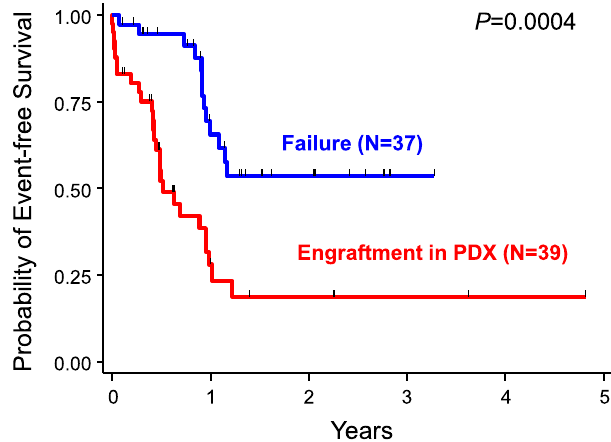
Fig. 5 Event-free survival of AML patients according to the establishment of AML-PDX. Kaplan – Meier estimates of event-free survival in 76 newly diagnosed AML patients according to the engraftment status in NOG mice. P -values were estimated from the Log-rank test. Source data are provided as a Source Data fi